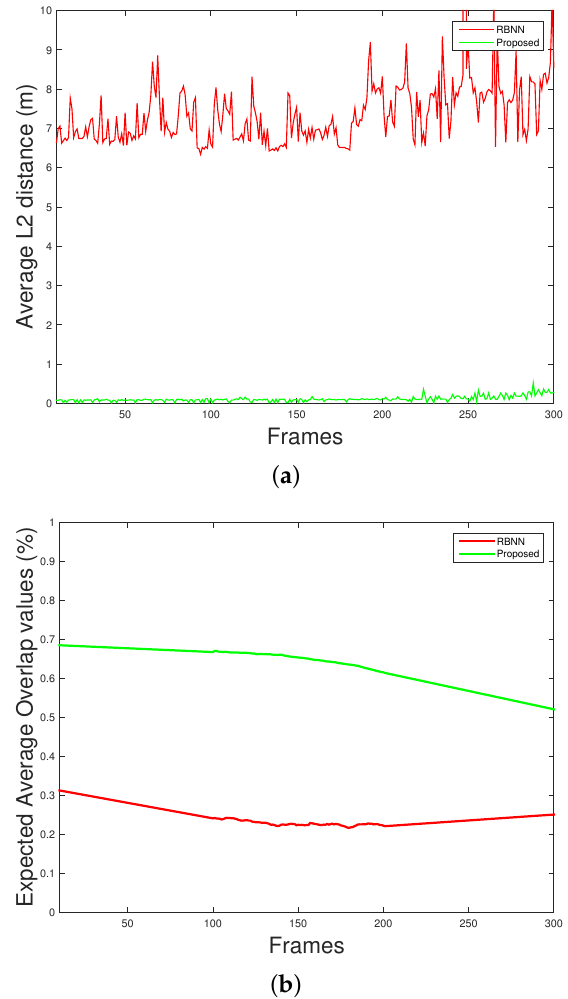
Figure 13. Overall performance measurement ( a ) Average L2, ( b ) expected average overlap